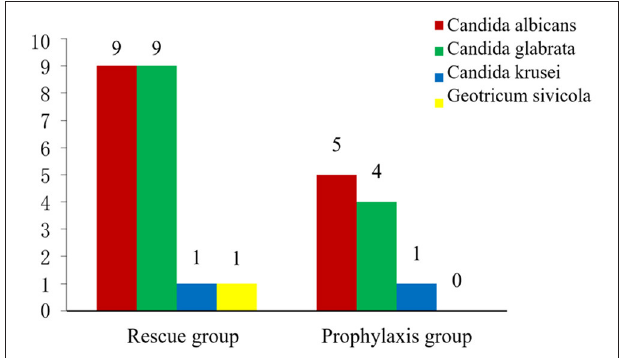
FIGURE 1 | The distribution of fungal species between two groups.